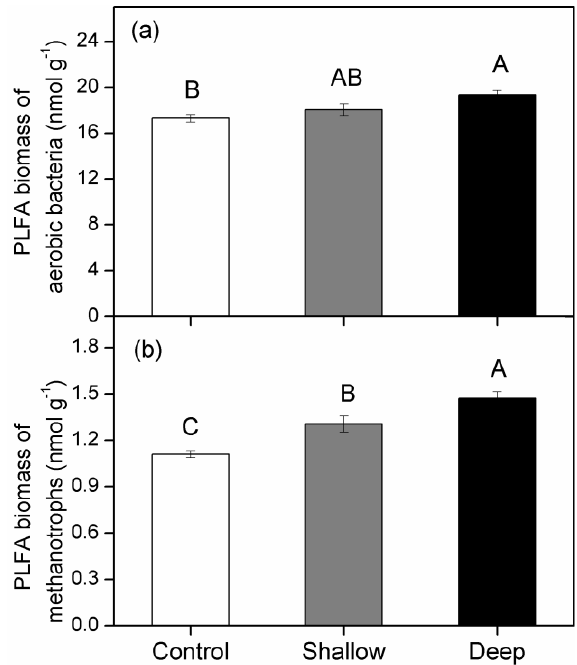
Figure 6. Phospholipid fatty acids (PLFA) biomass of (a) aerobic bacteria and (b) methanotrophs for the control, shallow and deep water table treatments in July 2016. Different letters indicate a significant difference among the control, shallow and deep water table treatments. Error bars represent ±1 Standard